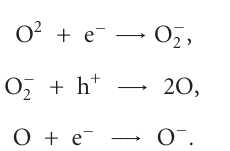
Table 1: Physical properties of mesoporous silica loaded with TiO 2